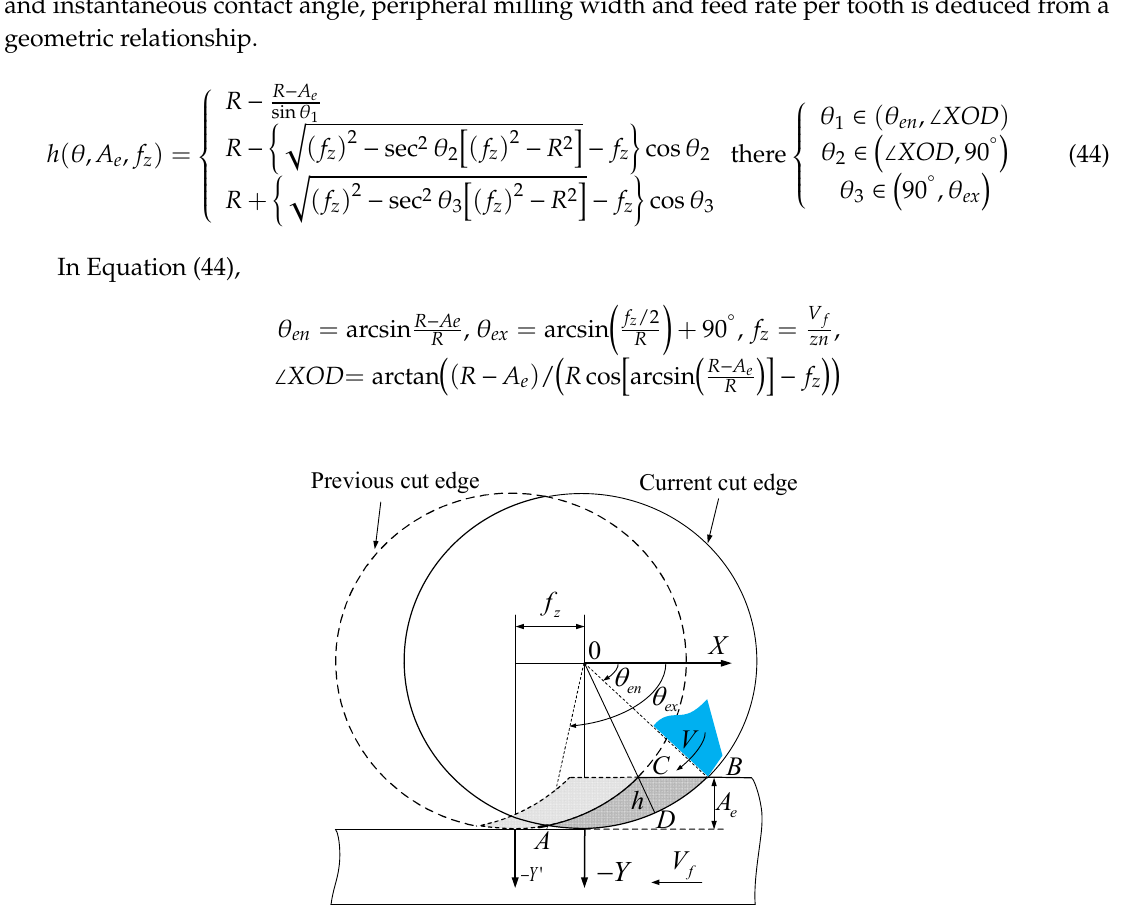
Figure 11. The diagram of undeformed chip thickness.